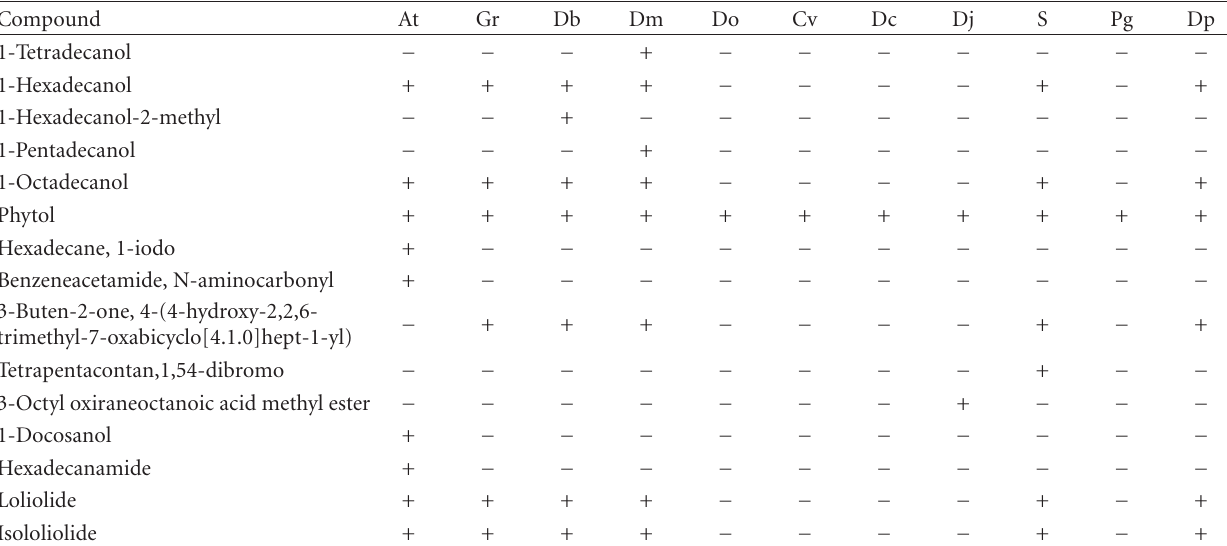
Table 4: Other apolar compounds found in seaweed species from Fernando de Noronha.